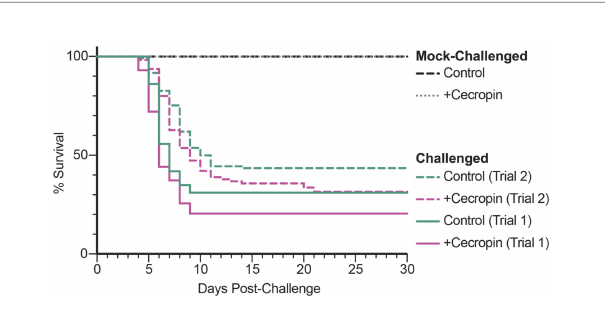
FIGURE 2 | Kaplan-Meier curve showing survival of fi sh fed either the control or the diet supplemented with cecropin A following an immersion challenge with Y. ruckeri . Each trial was analyzed independently. There were no statistical differences between the two diet groups for either trial according to the Gehan-Breslow-Wilcoxon test: p=0.15 for Trial 1, p=0.16 for Trial 2. No mortality was observed in mock-challenged fi sh fed either